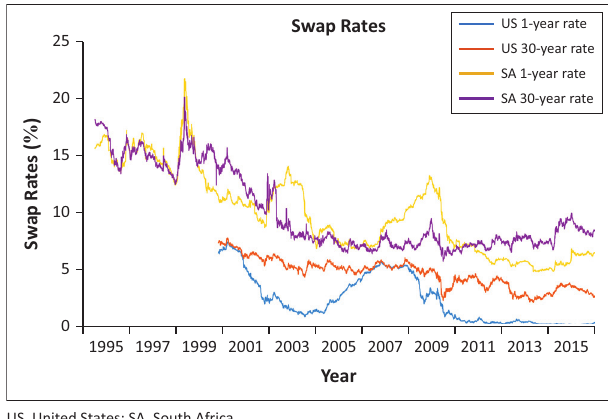
FIGURE 2: One-year and 30-year swap rates for both countries.